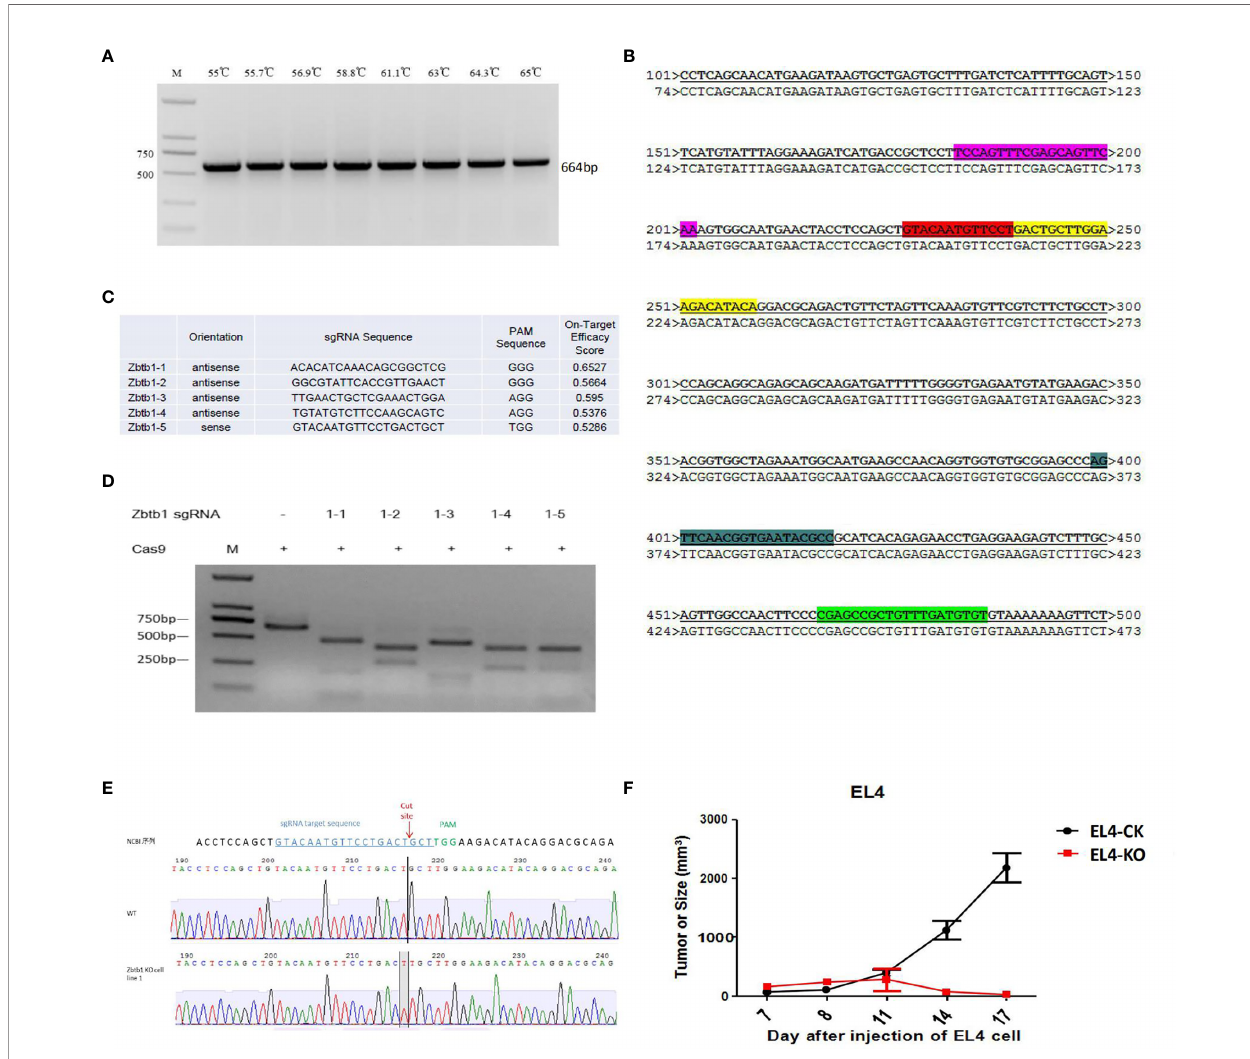
FIGURE 1 | (A) The target fragment of the EL4 cell genome was ampli fi ed by PCR; (B) The result of sequencing compared to the target sequence on NCBI. The highlighted part is the designed sgRNA sequence; (C) The design of 5 sgRNA sequences; (D) Zbtb1 sgRNA correctly mediates the cleavage function of Cas9 protein to the target fragment in vitro ; (E) Zbtb1 KO-EL4 cell lines were sequenced; (F) Comparison of growth rate of subcutaneously transplanted tumor in C57BL/6